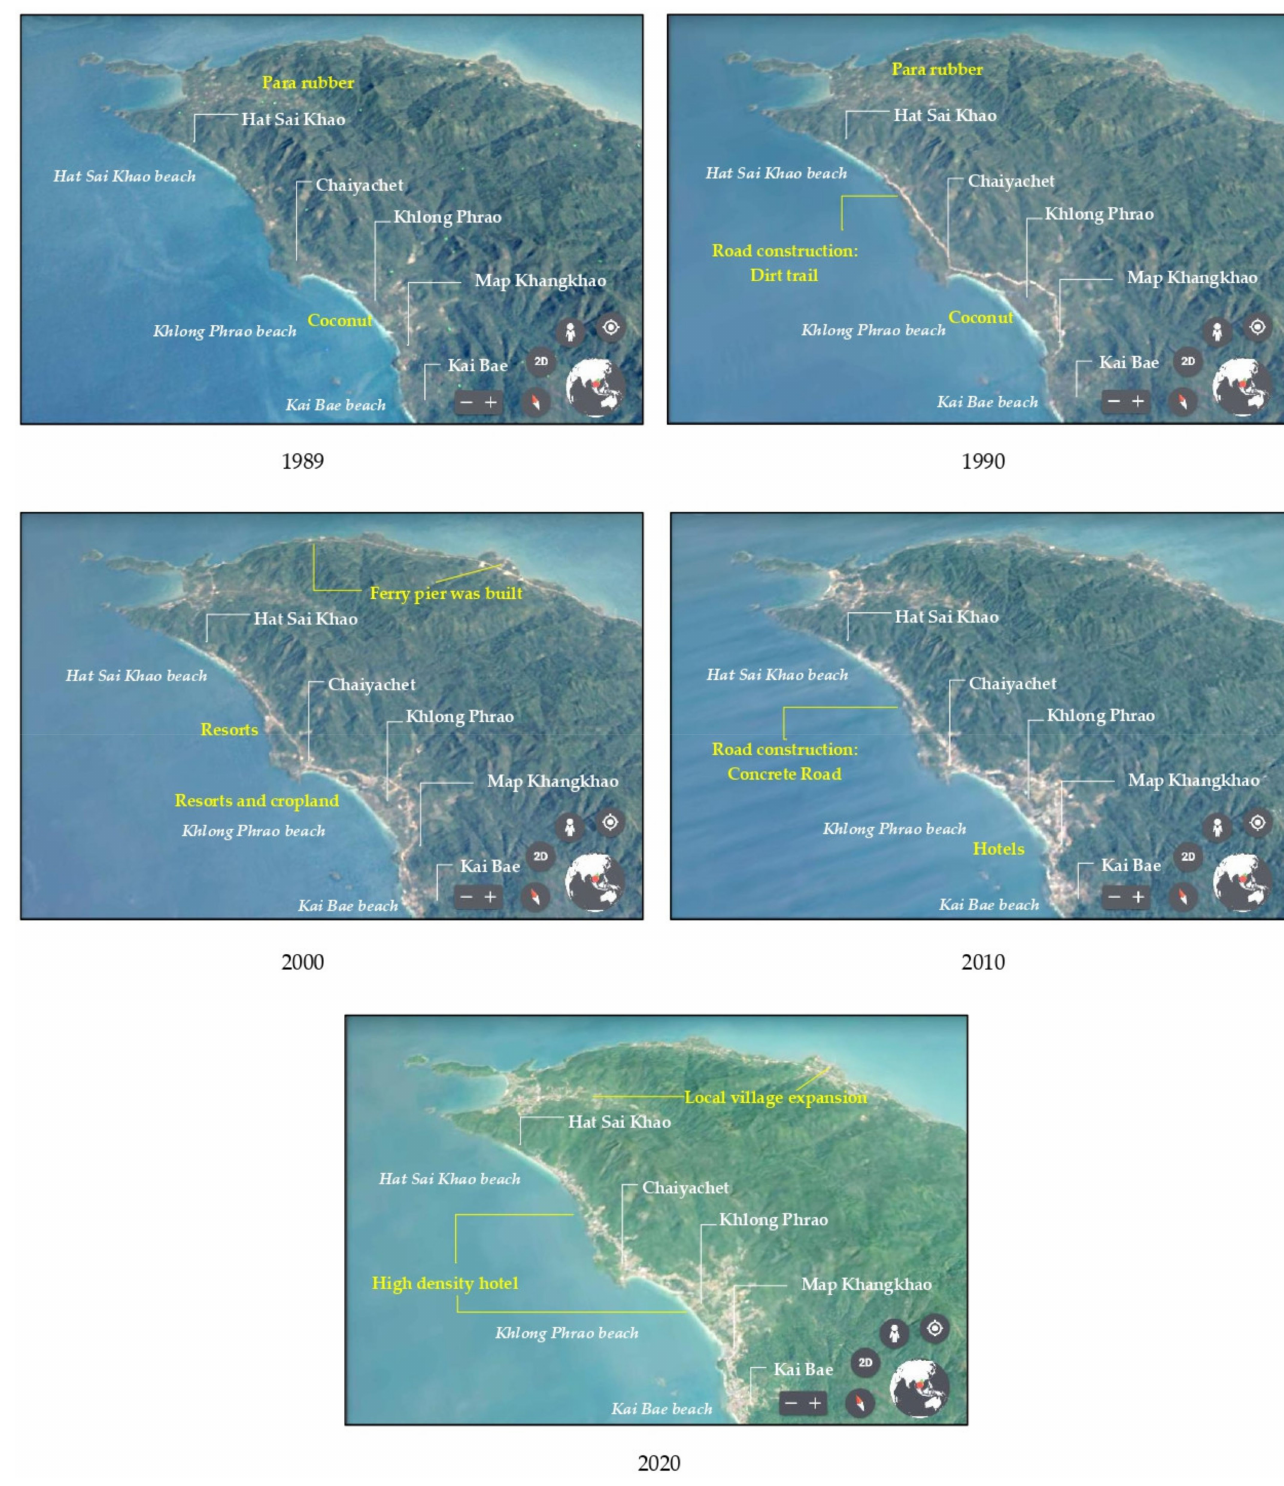
Figure 8. Spatial evolution from past to present in Koh Chang of Thailand. Map data 2021 © Maxar